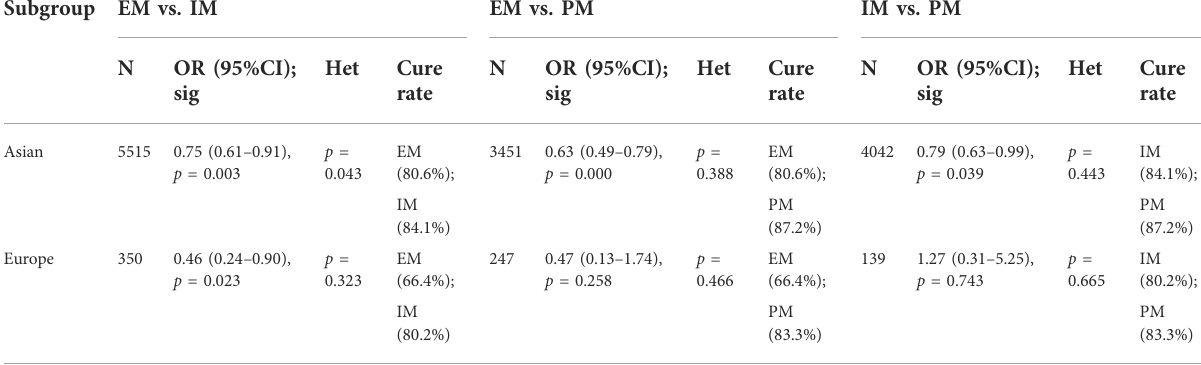
TABLE 6 Ef fi cacy of CYP2C19 polymorphisms on the cure rates of H. pylori in different geographical location of patients. Subgroup EM vs.